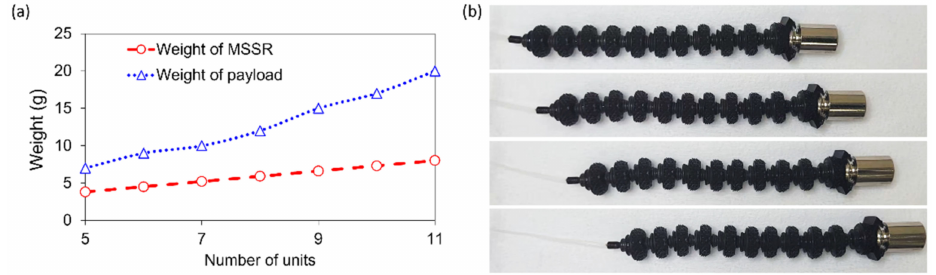
Figure 6. MSSR capable of delivering payload. ( a ) Change in payload weight that can be moved according to the number of units by adding a tong-type unit. ( b ) Images captured according to the cycle of delivering a weight 2.5 times the weight of the entire